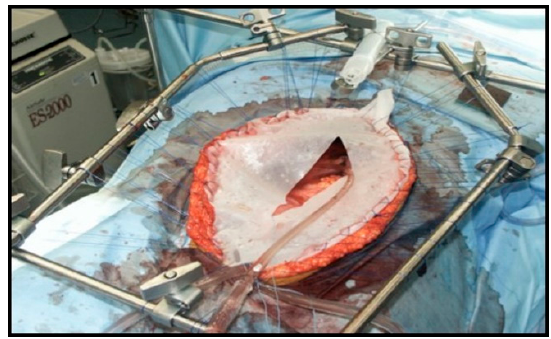
Figure 2. Coliseum HIPEC technique.